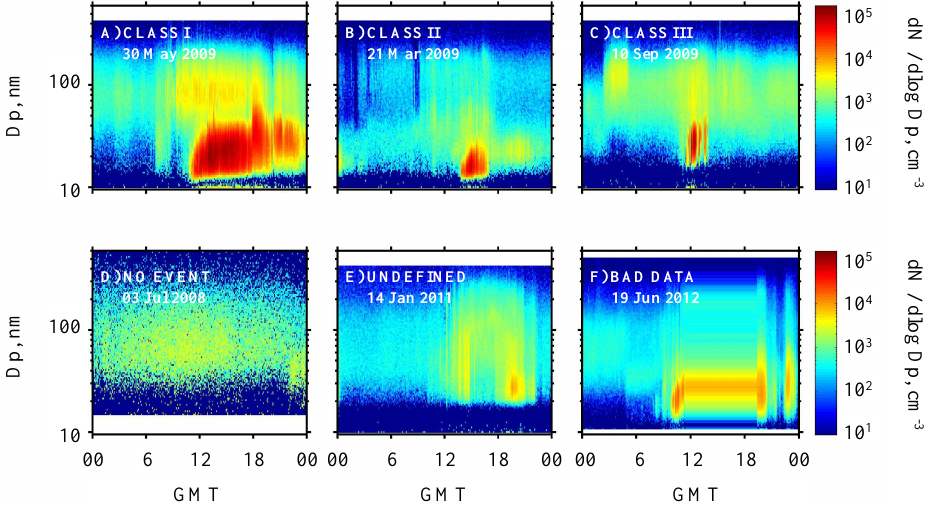
Fig. 3. Examples of type of events and cases identified in the data analysis.